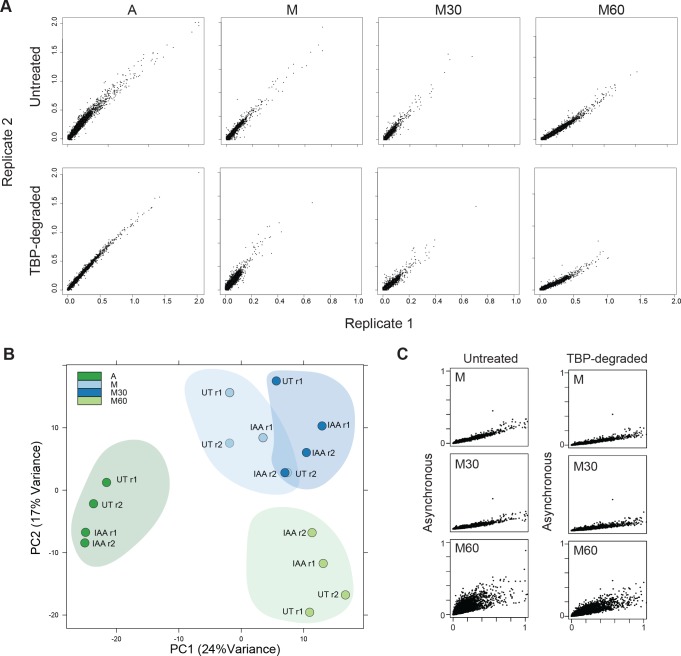
Nascent chr-RNA-seq is highly reproducible genome-wide.(A) For each gene, we quantified the intronic transcripts per million (TPM) reads and plotted a scatter plot with replicate one on the x-axis and replicate two on the y-axis for all samples. (B) Using the intronic TPM, we performed principal component analysis (PCA). This analysis shows that the replicates from each time point cluster together. (C) After combining reads from replicates, we calculated the TPB for each gene as before and plotted a scatter plot with the Asynchronous sample on the y-axis, and the indicated sample on the x-axis. This analysis shows that the M and M30 samples show decreased TPM relative to asynchronous (A) samples. The M60 of untreated samples are getting closer to the diagonal, suggesting that gene expression has largely re-established the asynchronous profile. For TBP-degraded samples (right), the scatter plot shows levels largely under the diagonal, suggesting a global delay in gene reactivation.